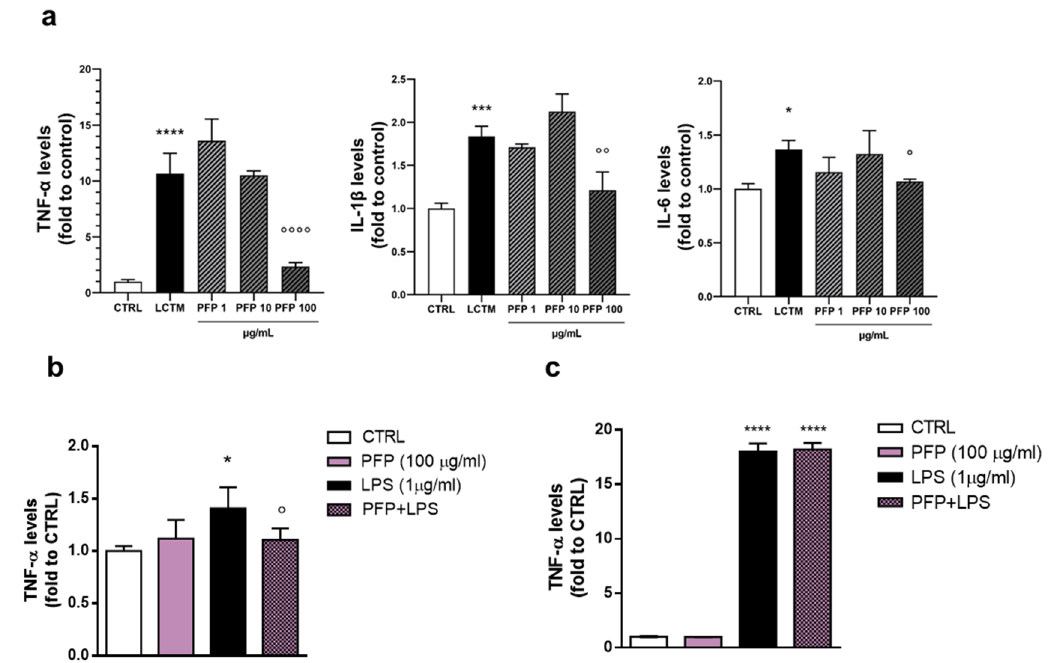
Figure 5. Effect of PFP (1, 10, 100 µg/mL) treatment on ( a ) TNF-α, IL-6, or IL-1β release analyzed by ELISA assay in HaCaT cells exposed to LPS-conditioned THP-1 medium (LCTM) for 24 h; ( b ) TNF-α in HaCaT cells stimulated by LPS (200 ng/mL) for 24 h; ( c ) TNF-α in THP-1 cells exposed to LPS 1 µg/mL) for 24h h. Each column represents mean ± SD. Data were analyzed by one-way analysis of variance followed by Tukey:* p < 0.05, *** p < 0.001,**** p < 0.0001 vs. CTRL; ° p < 0.05,°° p < 0.01, °°°° p < 0.001 vs. LCTM or LPS.